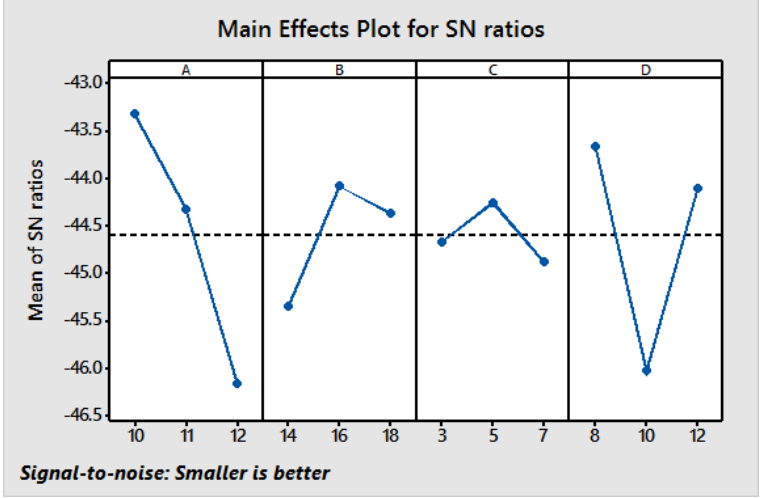
Table 5. Response table for means of signal-to-noise (S/N) ratios.